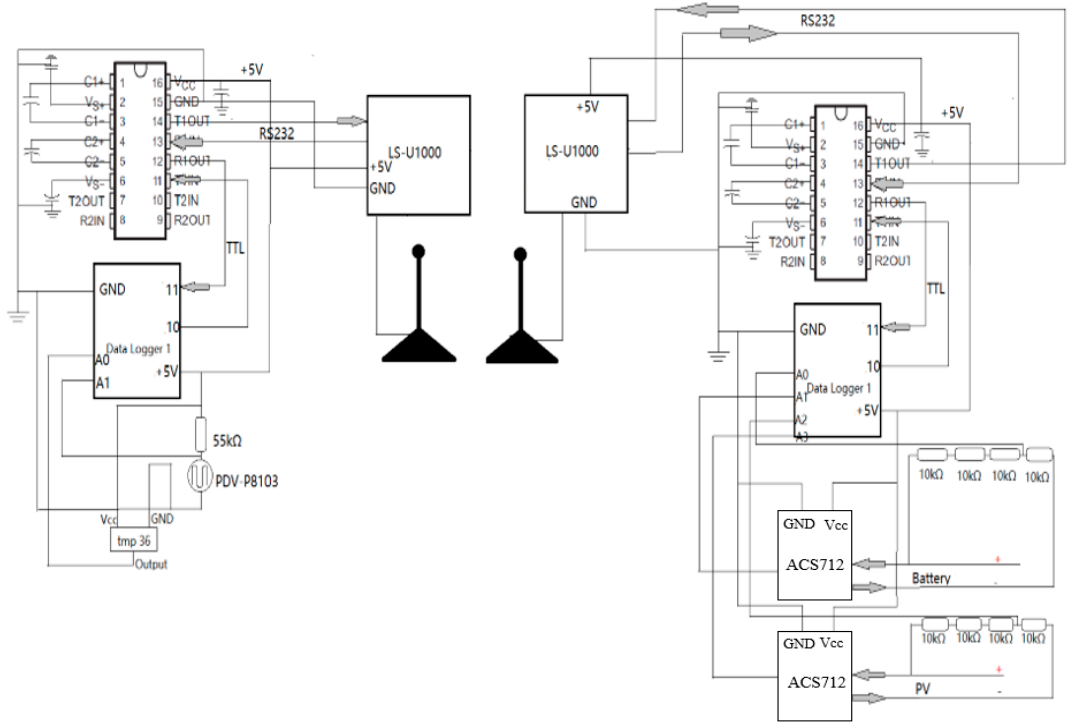
Figure 4. Detailed wiring diagram of data logging system.